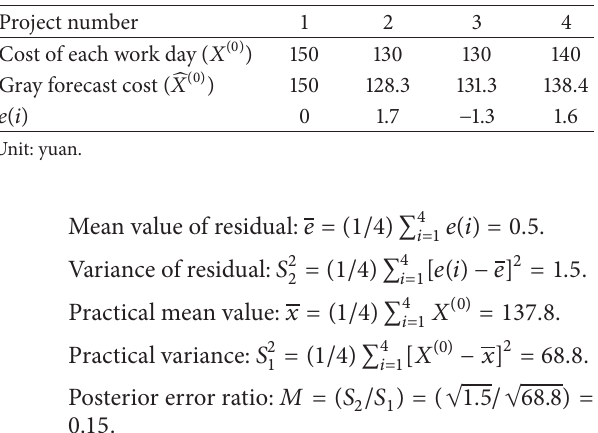
Table 3: Result of accuracy